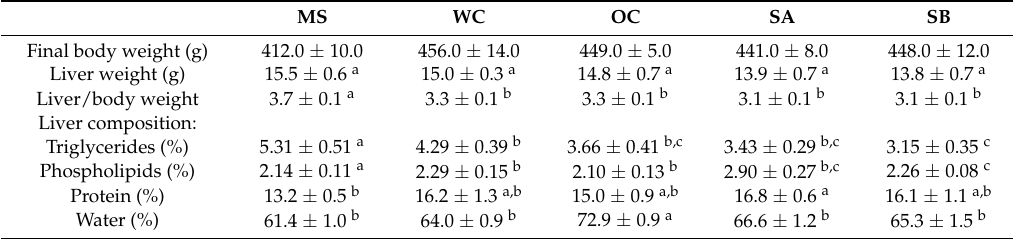
Table 1. Final body weight, liver weight, and liver composition of experimental groups.